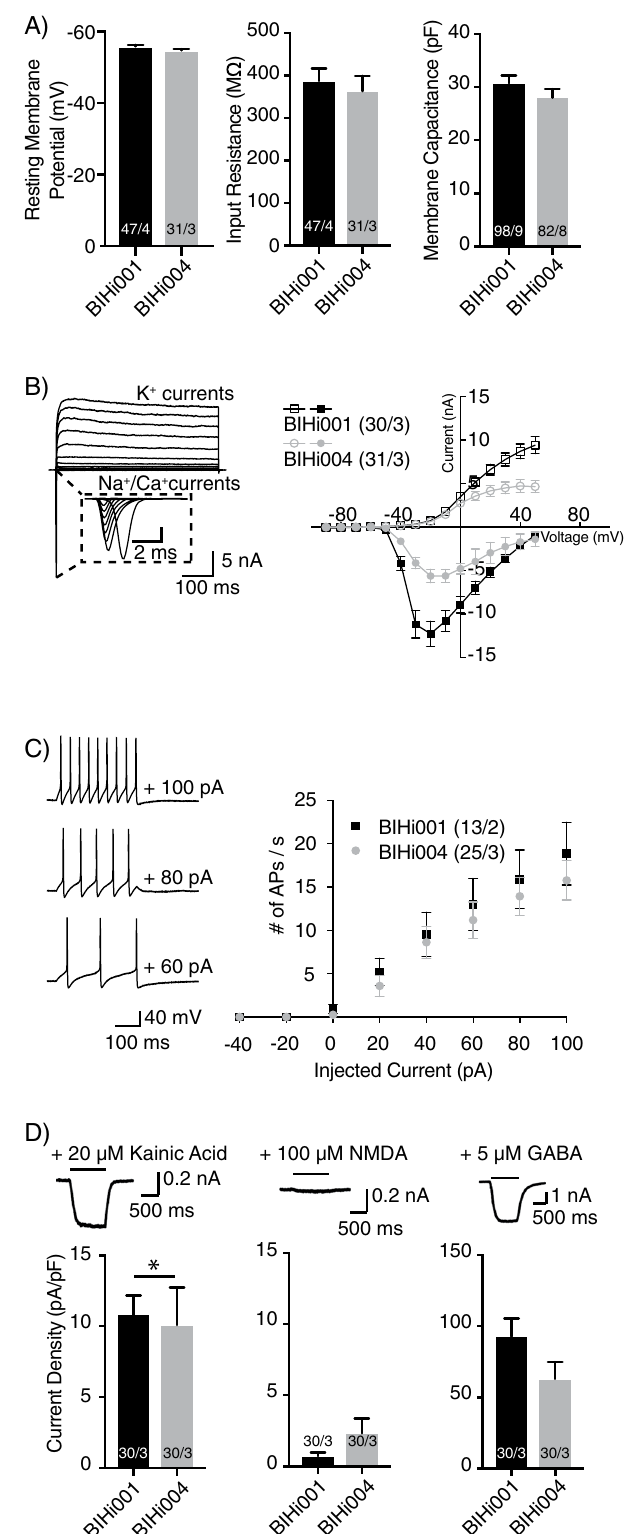
Figure 2. Passive membrane properties and ion channel characteristics of iNs in autaptic culture. ( A) Average resting membrane potential, input resistance and membrane capacitance of autaptic iNs. ( B) Representative traces (left) and quantitative analysis of whole-cell voltage-clamp Na + /Ca 2 + and K + -currents (right). ( C) Representative traces (left) and quantitative analysis of the number of APs per second elicited by current injections in current-clamp recordings (right). ( D) Quantification of whole-cell currents evoked by